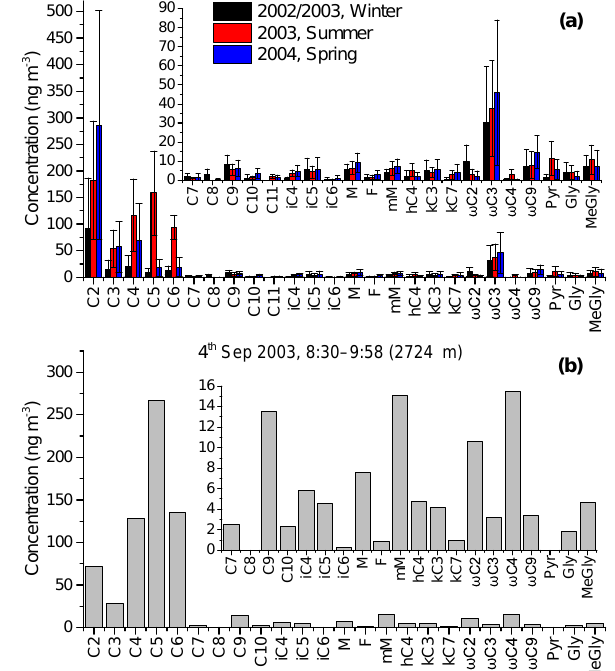
Figure 2. Molecular distributions of straight chain diacids (C 2 – C 11 ), branched chain diacids (iC 4 –iC 6 ), unsaturated diacids (M, F and mM), multifunctional diacids (hC 4 , kC 3 and kC 7 ), ketoacids ( ω C 2 – ω C 4 , ω C 9 and Pyr), and α -dicarbonyls (Gly and MeGly) in aircraft measurement over China; (a) averaged concentrations with bars of standard deviation during winter 2002/2003, summer 2003 and spring 2004; (b) molecular distributions of the measured com- pounds in the sample collected on 4 September 2003. See Table 1 for